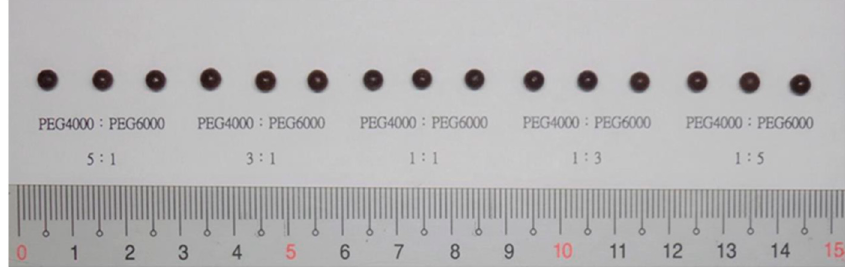
Figure 2. Dropping pills prepared using different ratios of PEG4000 and PEG6000.